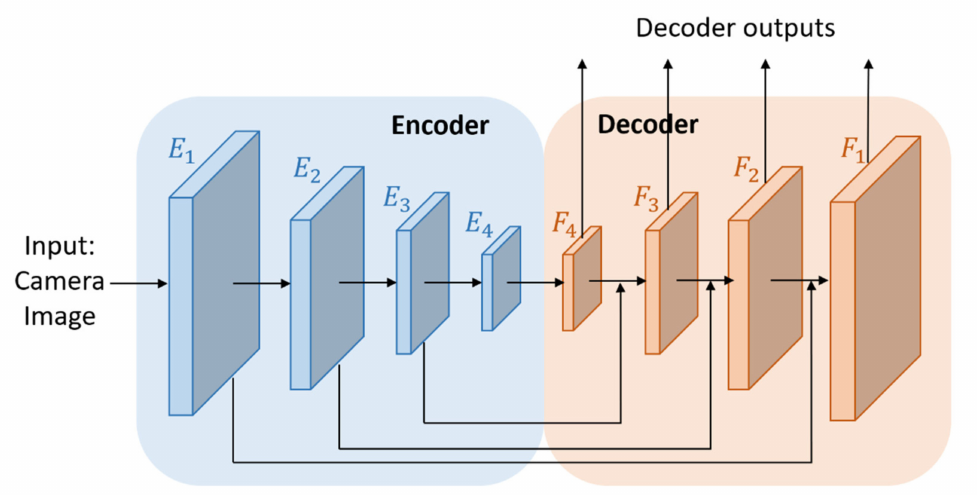
Figure 2. Encoder-Decoder Fusion (EDF) module